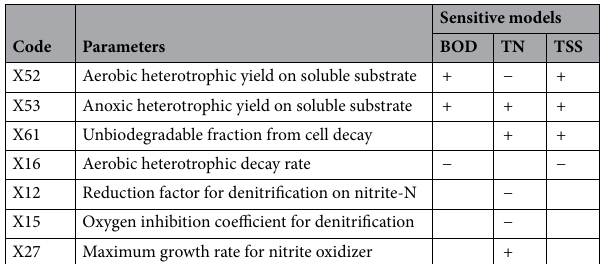
Table 3. Models sensitive to parameters identified as influential by MoM with polarity.